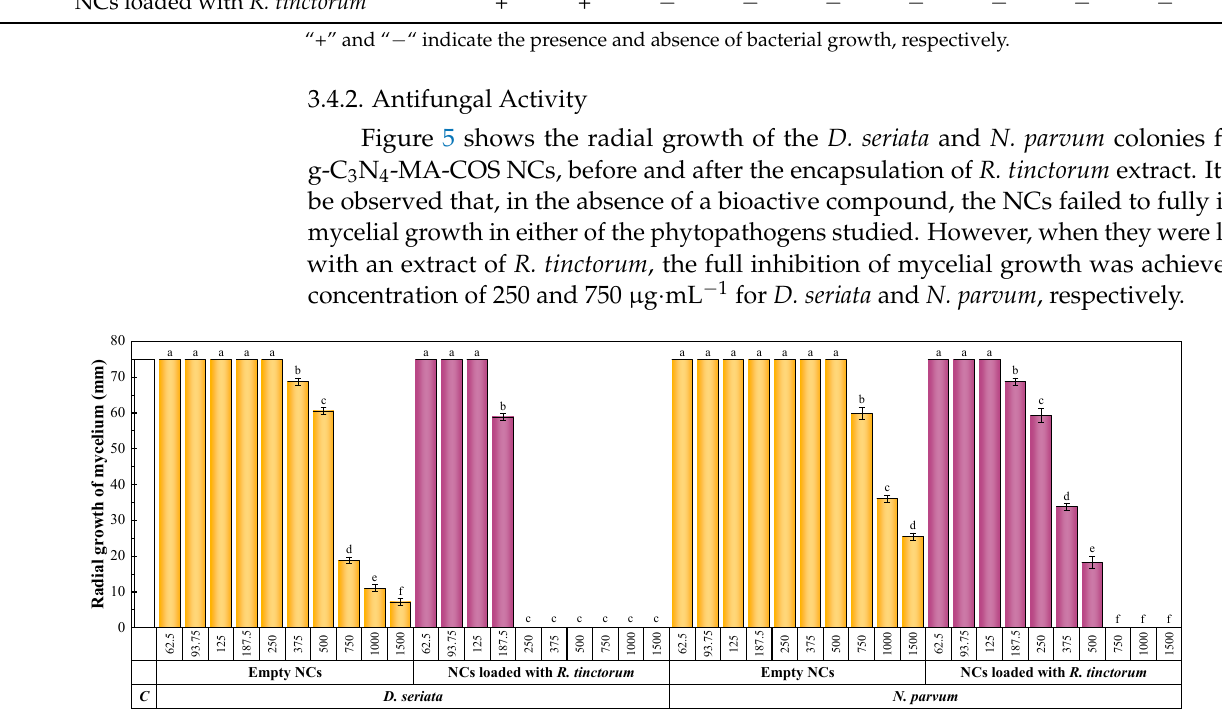
Figure 5. Diameter (in mm) of the mycelial growth of D. seriata and N. parvum for different concentrations of the g C 3 N 4 -MA-COS nanocarriers, before and after the encapsulation of R. tinctorum extract. The letters above concentrations indicate that they are not significantly different at p < 0.05. ‘C’ and ‘NCs’ stand for control and nanocarriers, respectively.